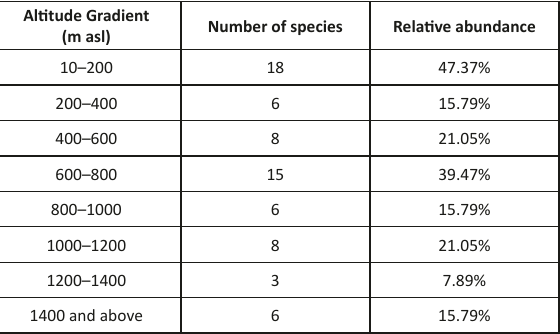
Table 5. Relative abundance of Scolopendromorpha across altitudinal gradient Altitude Gradient (m